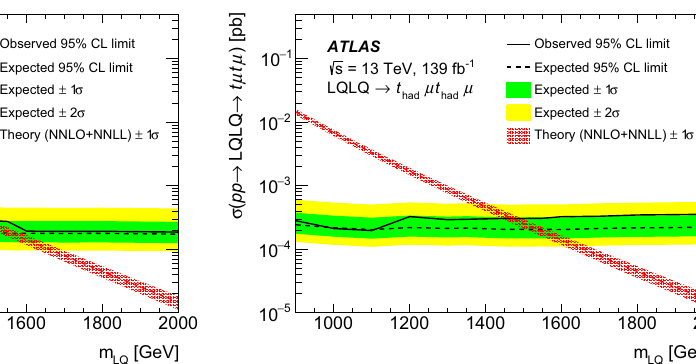
Fig. 4 Fit results (background-only) for the binned BDT output score distribution in the signal region of the electron (left) and muon (right) channel, and the overall number of events in the t ¯ t and Z + jets control